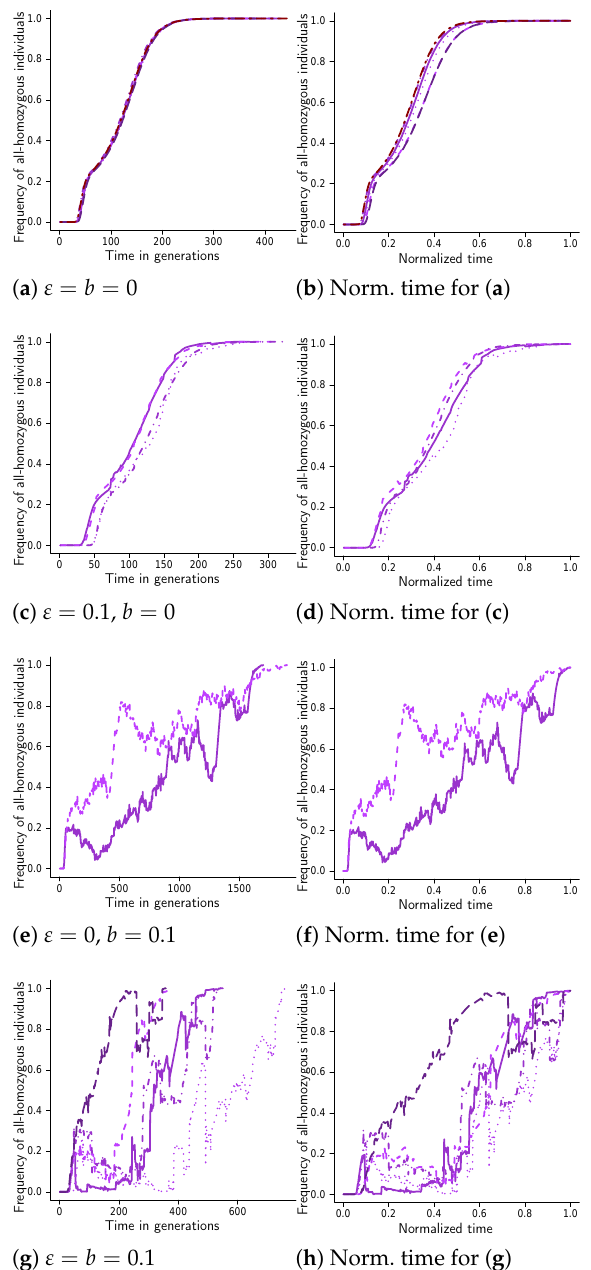
Figure A7. Three sites with weight function as in Equation (A4). Examples of fixation trajectories for fixation at three sites with weight function as in Equation (A4), carrying capacity C = 10 6 , cutoff u ( N ) = C , probability of recombination r = 0.25 between adjacent sites, α 1 = 0.75, α 2 = 3, ε (see Equation (7)) and probability of a bottleneck b as shown, strength of selection s = 0.1 and bottleneck B = 10 3 . In ( a , c , e ) trajectories from ten experiments, in ( g ) from 10 2 experiments. Each trajectory traces, as a function of time, the number of diploid individuals homozygous for the fit type at all sites relative to the population size (the number of diploid individuals). The panels on the right ( b , d , f , h ) show the corresponding excursions from the left panels ( a , c , e , g ), where the time to fixation for each excursion is normalized by the time to fixation for the excursion. The scale of the abscissa (time axis) may vary between panels; in each panel, the trajectories were all obtained under identical